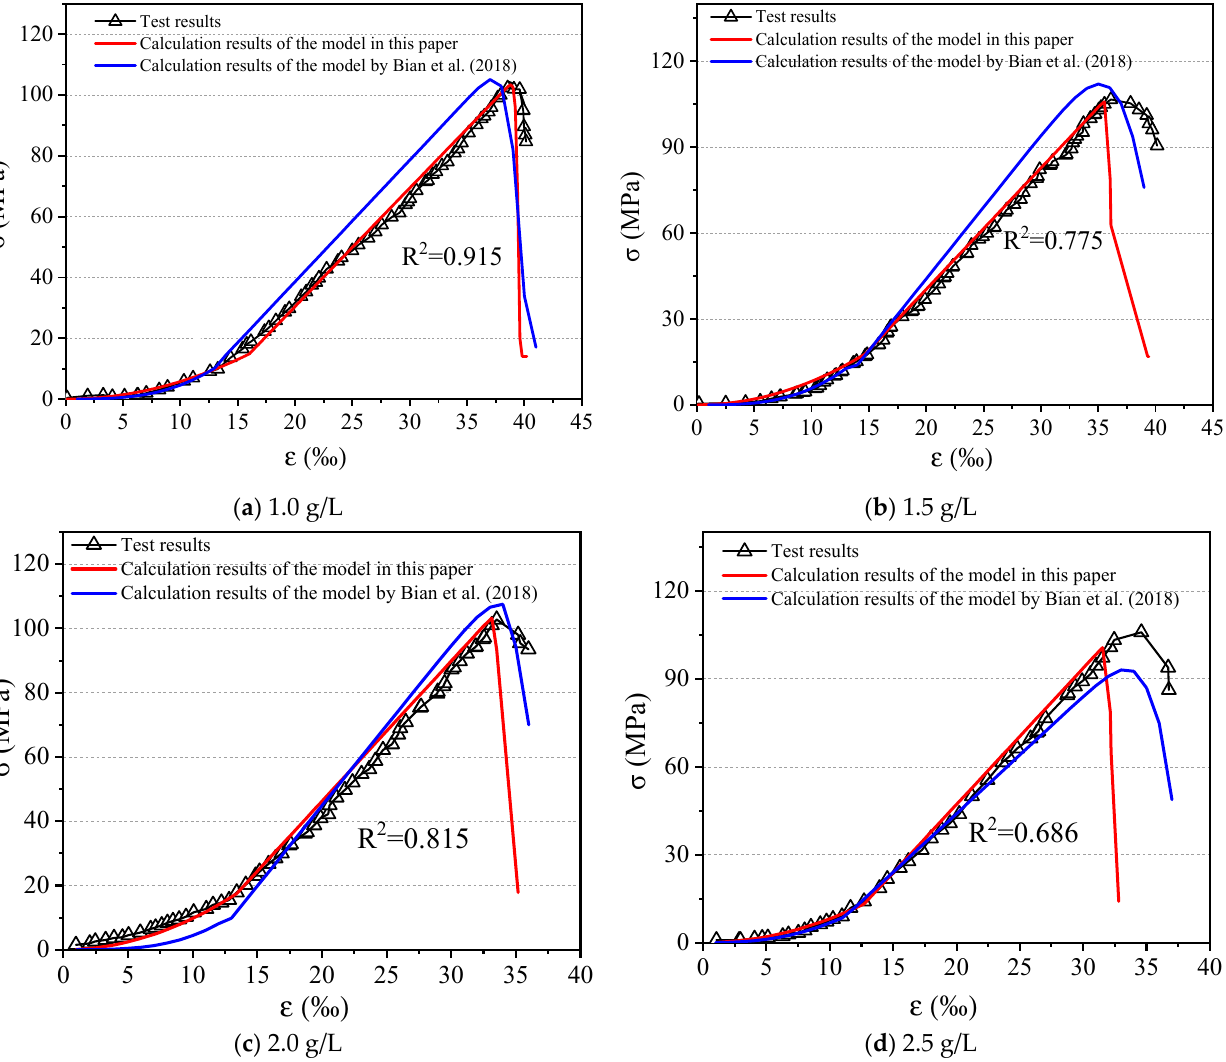
Figure 2. Comparison of the experimental and theoretical results with different Fe 3+ concentra- tions.